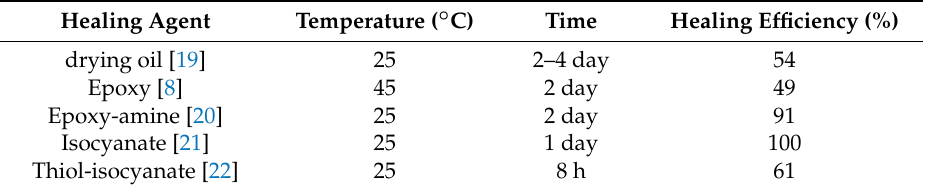
Table 1. The self-healing properties of different healing